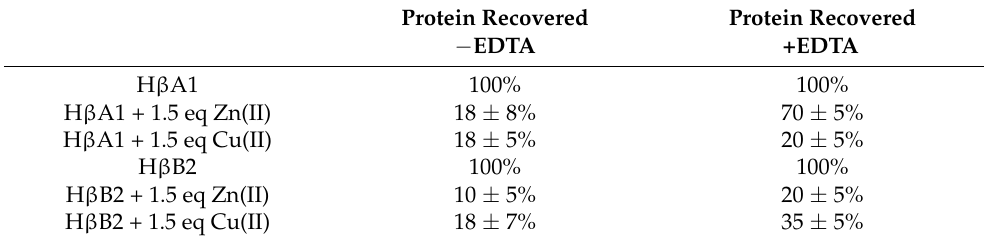
Table 1. Soluble protein. H β A1 and H β B2 with and without